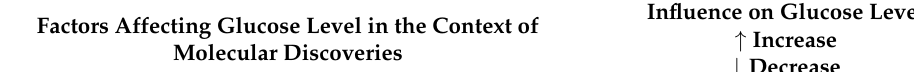
Table 2. Factors affecting glucose fluctuations in the context of molecular